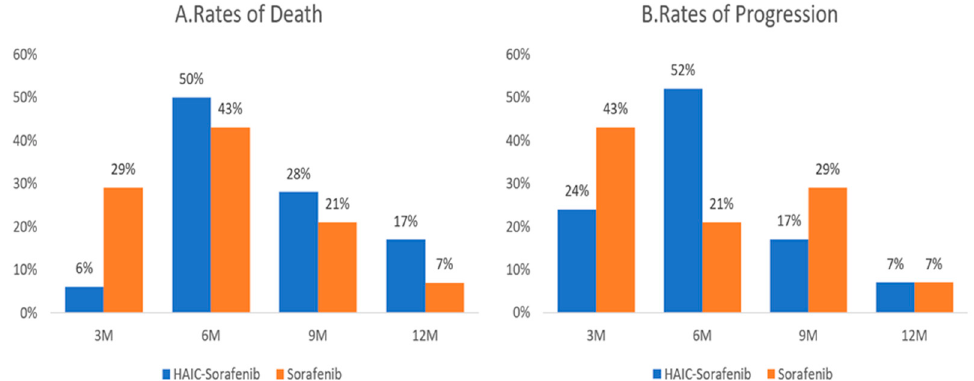
Figure 1. Percentages of death ( A ) and progression ( B ) by treatment strategy at 3 M, 6 M, 9 M, and 12 M (M, months).